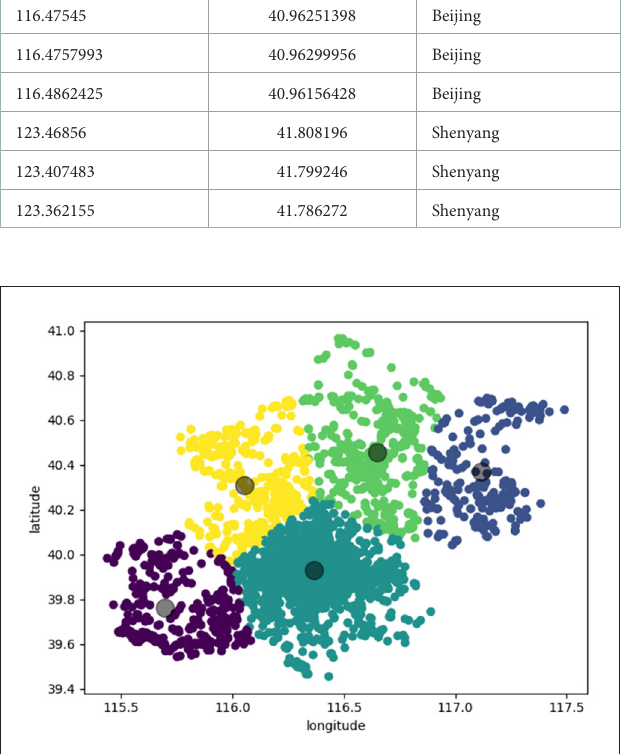
FIGURE5 PSO algorithm attractions clustering distribution